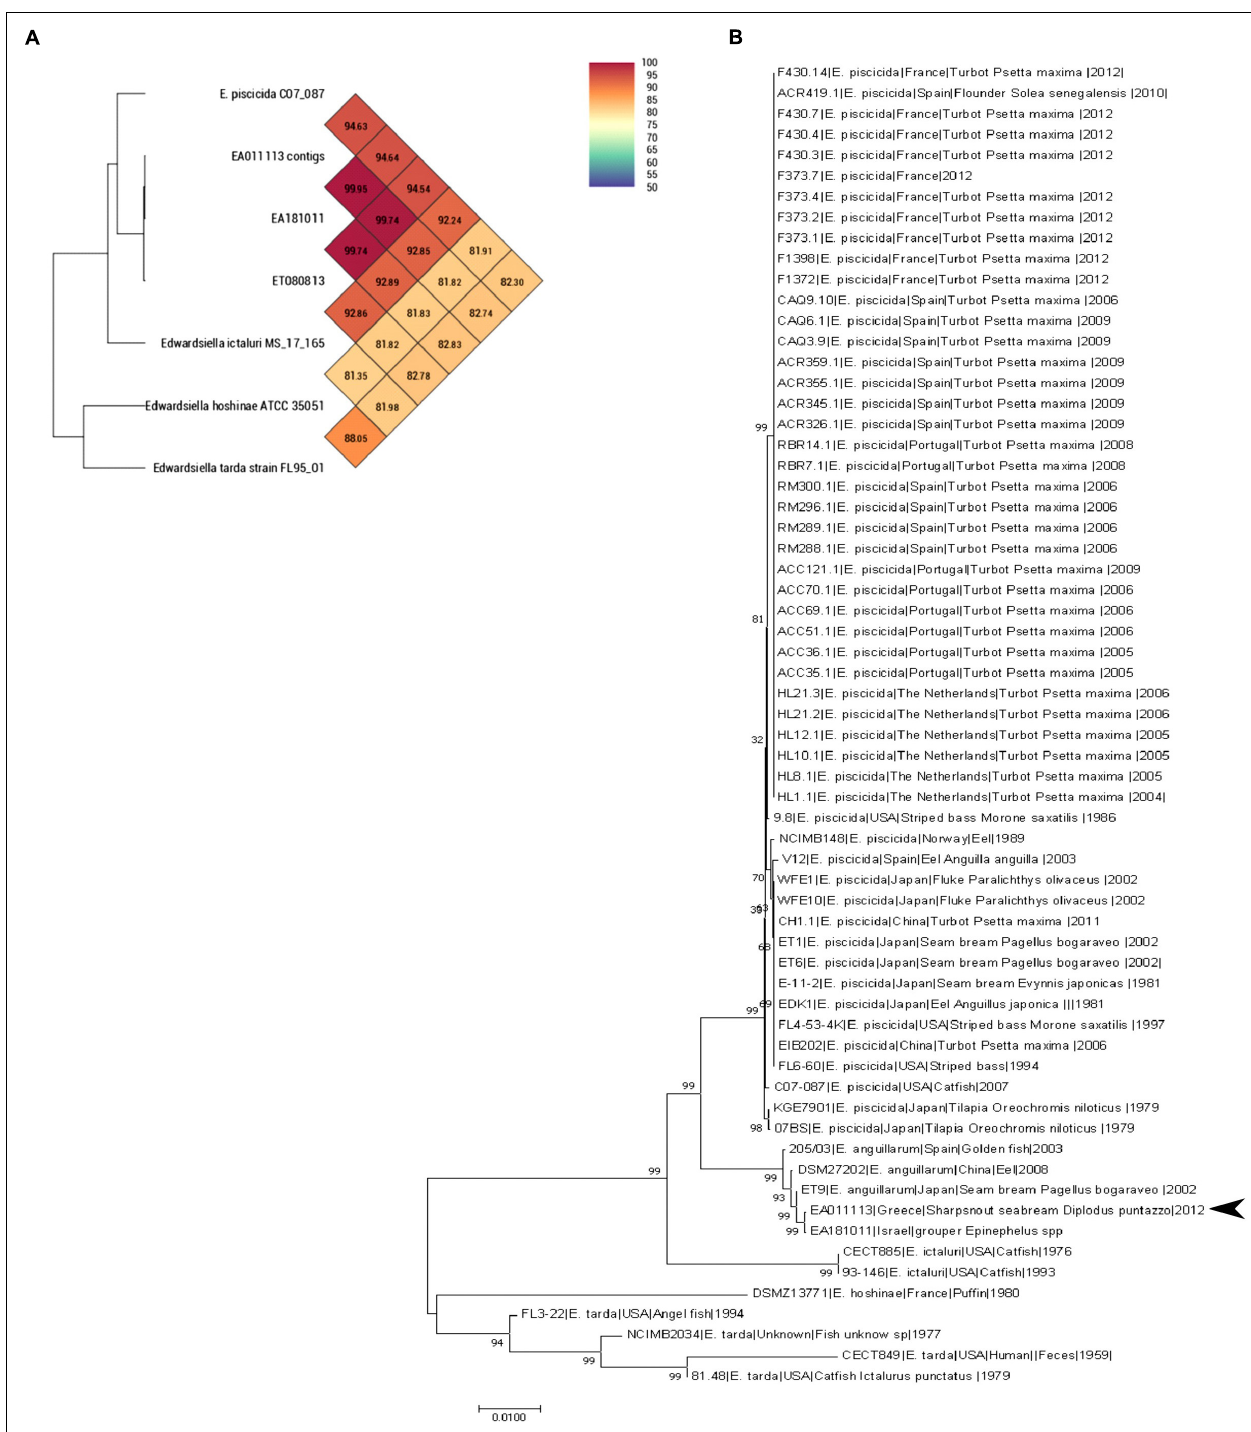
FIGURE 1 | (A) OrthoANI values (% nucleotide level genomic similarity) of the EA011113 against other Edwardsiella spp. (B) MLST analysis of all available Edwardsiella species in the BIGSdb. Phylogenetic tree was build using Neighbor-joining method with 1000 bootstraps. EA011113 forms a distinct cluster with the other E. anguillarum strains. There were a total of 6617 positions in the final dataset.